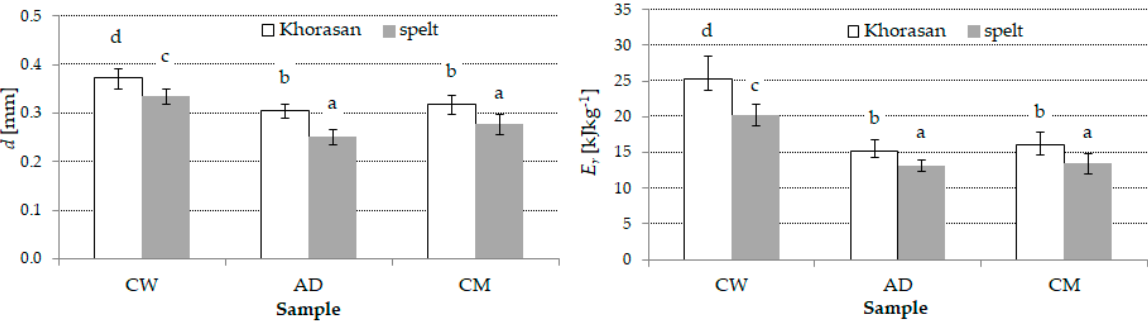
Figure 1. Average particle size ( d ) and specific grinding energy ( E r ) of the control wheat (CW) and the dried wheat (AD = air-dried wheat, CM = wheat stored in the climatic chamber). The values in columns designated with different letters are statis- tically significantly different ( p < 0.05).